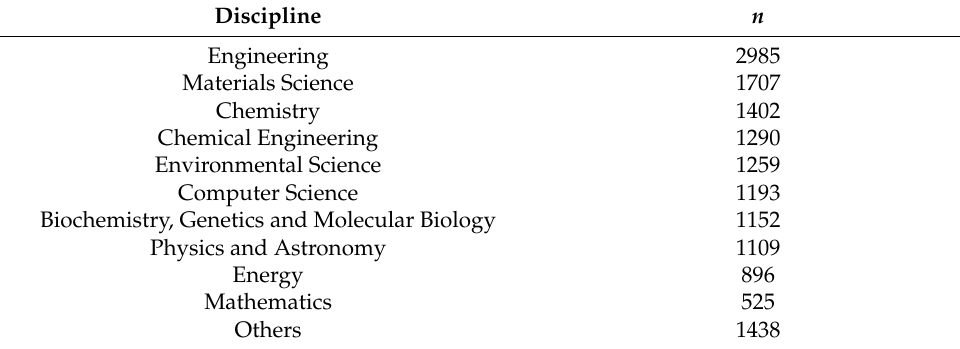
Table 2. Number ( n ) of publications per each subject category as a different discipline.